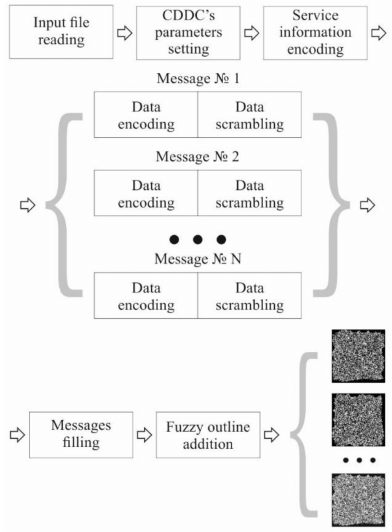
Figure 3. The algorithm of MCDDC data